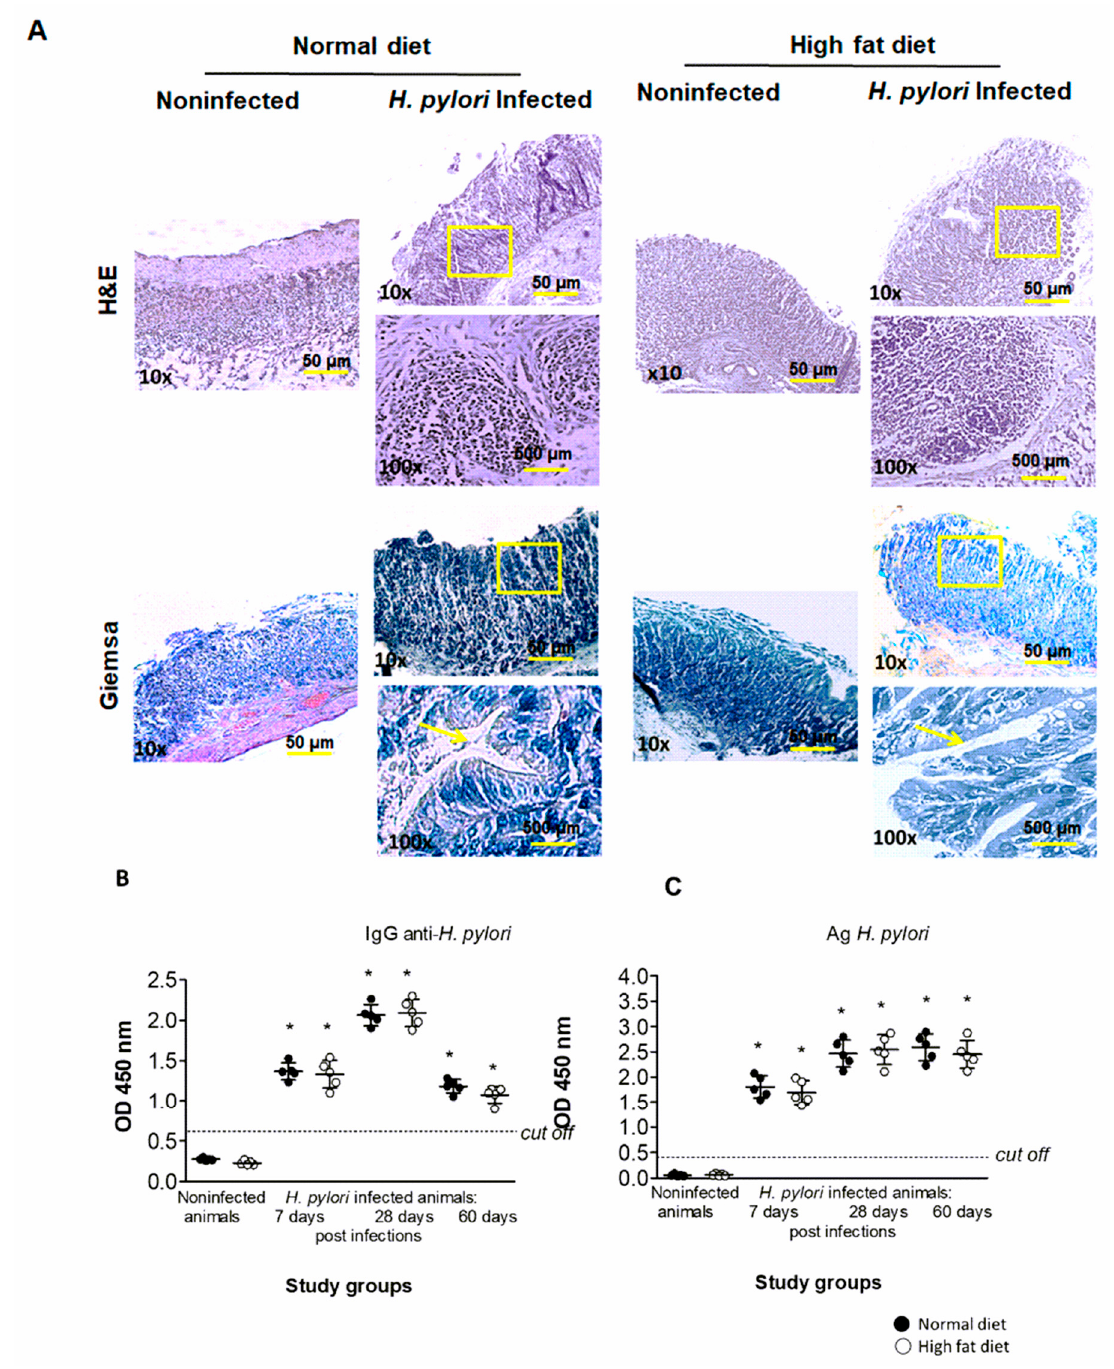
Figure 1. Histological and serological assessment of H. pylori infection in the experimental guinea pig model. ( A ) Representative images of the Giemsa- and H&E-stained thin layer sections of gastric tissue from uninfected or H. pylori -infected animals after 60 days from inoculation. Uninfected or H. pylori -infected animals were exposed to normal chow (left panel) or an experimental high-fat diet (right panel). Stained sections were analyzed using light microscopy (magnification × 100, × 400). The yellow arrows show the location of Helicobacter -like organisms (HLO). ( B ) The serum level of anti- H. pylori IgG and ( C ) the detection of H. pylori antigens (Ag) in stool samples of uninfected and H. pylori -infected guinea pigs after 7, 28 and 60 days from inoculation. Five animals per group were examined. The results are presented as the median values of four independent experiments performed in triplicates for each experimental variant. Statistical analysis was performed with the nonparametric Kruskal–Wallis test. Statistical significance, * p < 0.05, was obtained for H. pylori- infected animals (7, 28 and 60 days after inoculation) fed chow or a high-fat diet vs. the control animal.